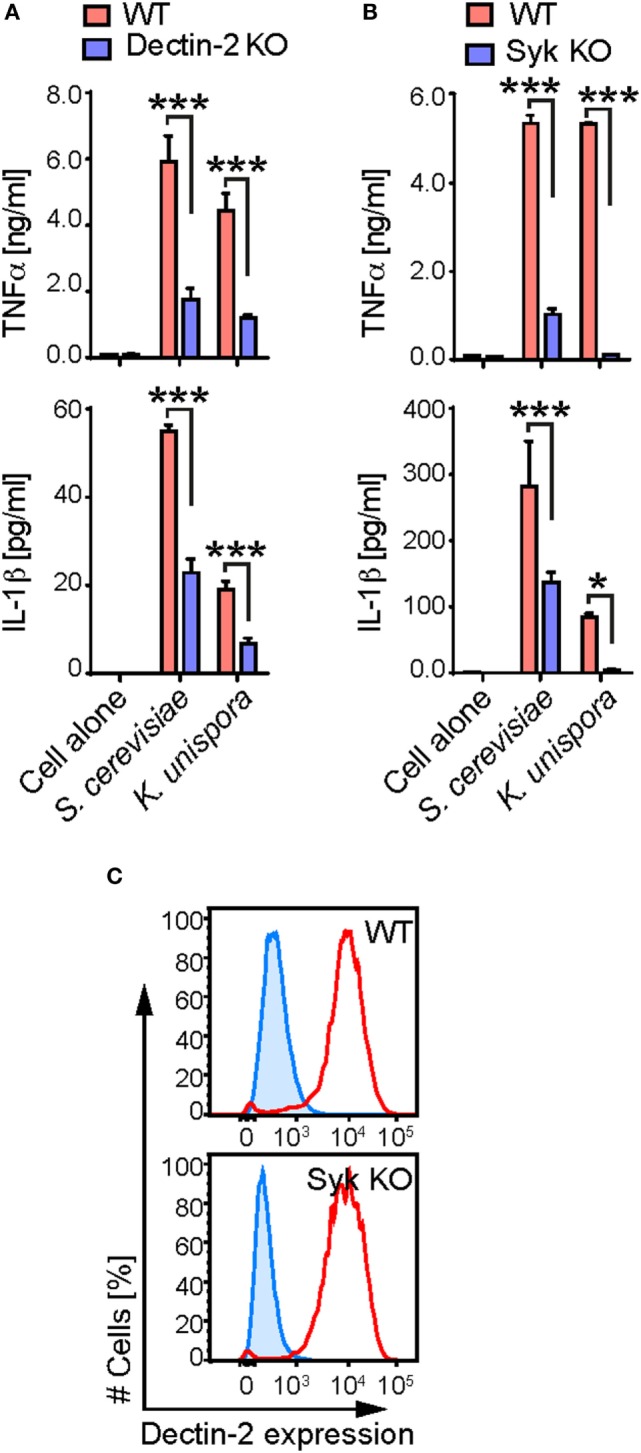
Dectin-2 and Syk-dependent cytokine production by gut commensal yeasts. (A,B) WT, Dectin-2, and Syk KO BMDCs were incubated with the indicated yeasts at a multiplicity of infection of 5. After 16 h incubation, the supernatant was harvested, and the amount of TNFα and IL-1β was measured by ELISA. (C) WT and Syk KO BMDCs were stained with anti-Dectin-2 Ab (red) or the isotype-control Ab (blue). The stained cells were analyzed by flow cytometry. Data shown are the mean of triplicates ± SD from one representative experiment and reproducible in three independent experiments. Statistical analyses were performed by one-way ANOVA followed by Tukey’s test.